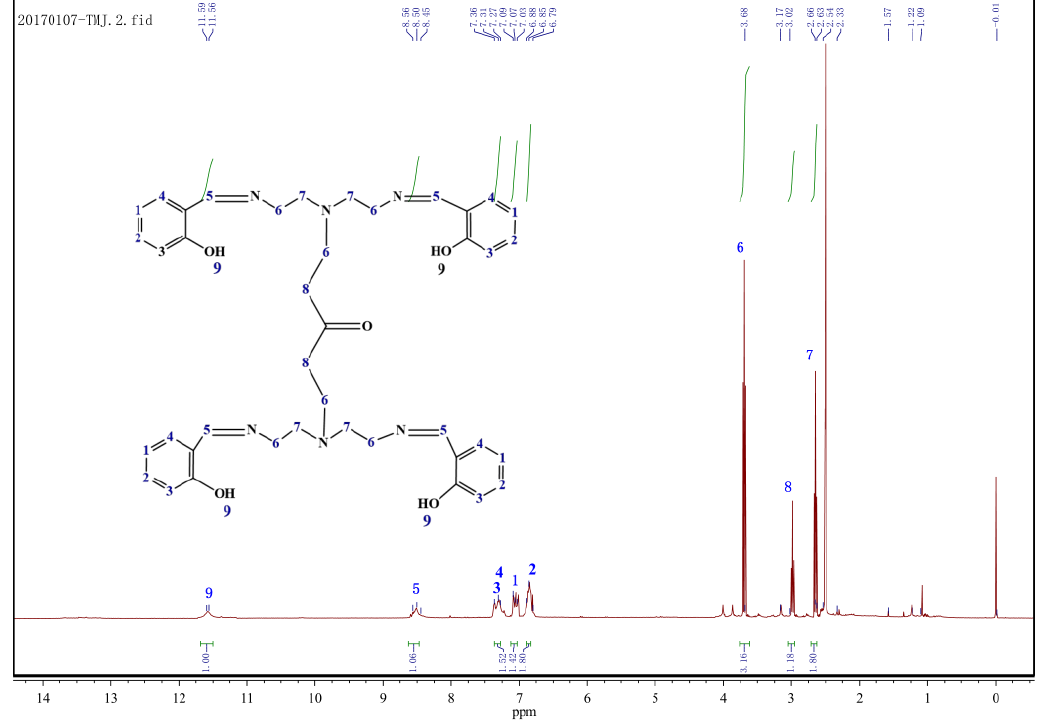
Figure 2. 1 H NMR spectrum of MBT.